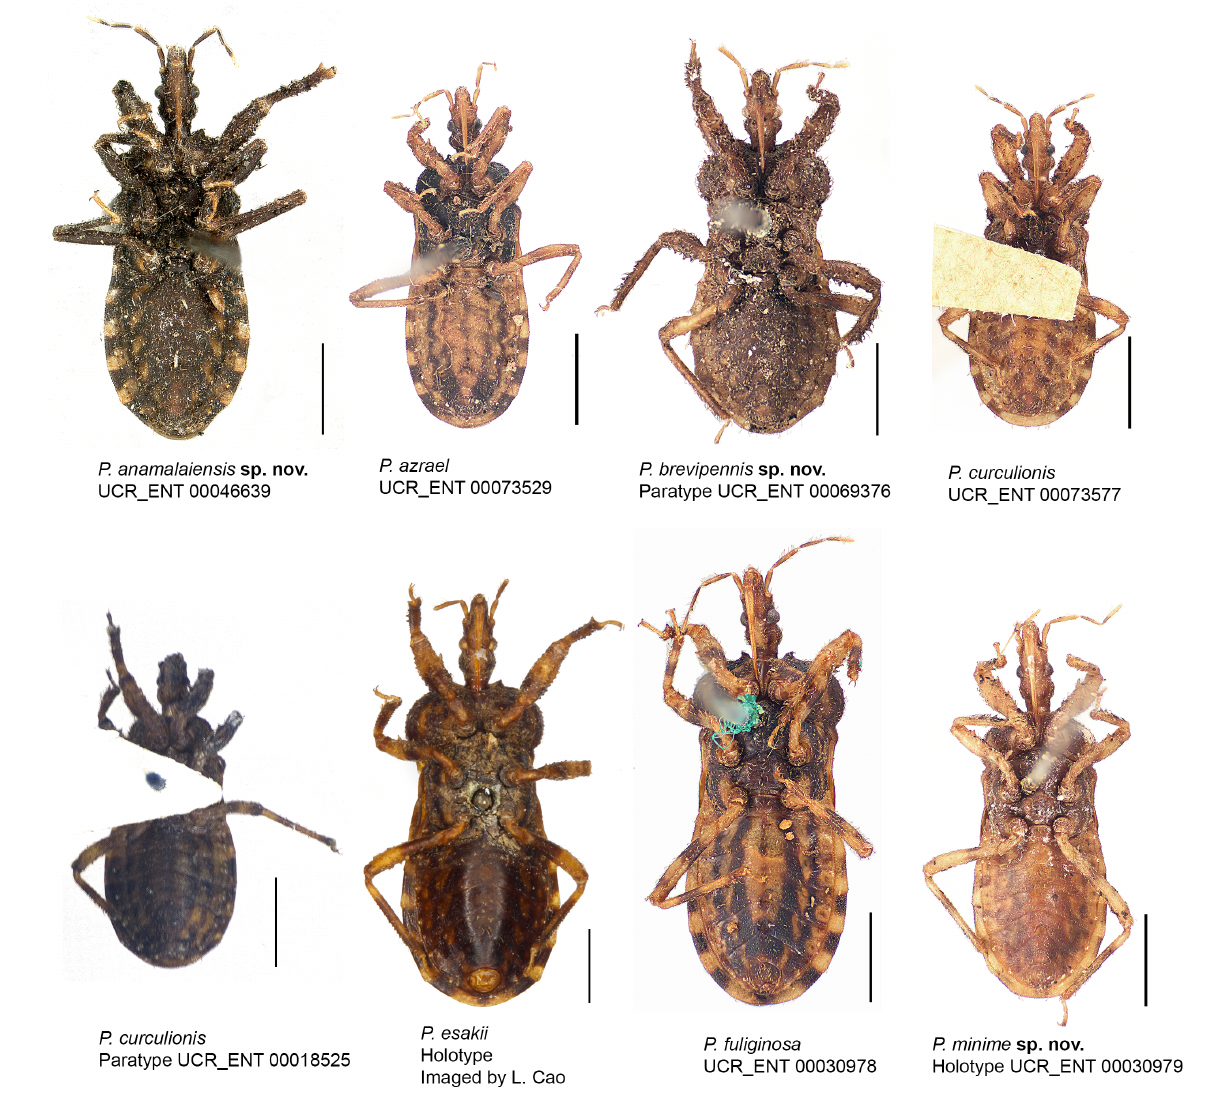
Fig. 17. Ventral habitus images for species of Physoderes Westwood, 1845 (partial). Scale bars = 2